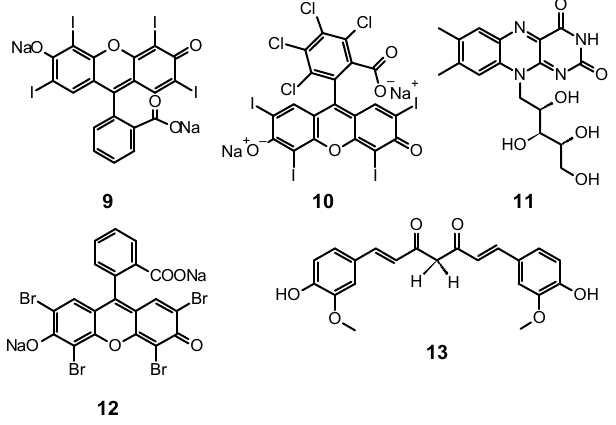
Figure 4. Chemical structures of ( 9 – 13 ).